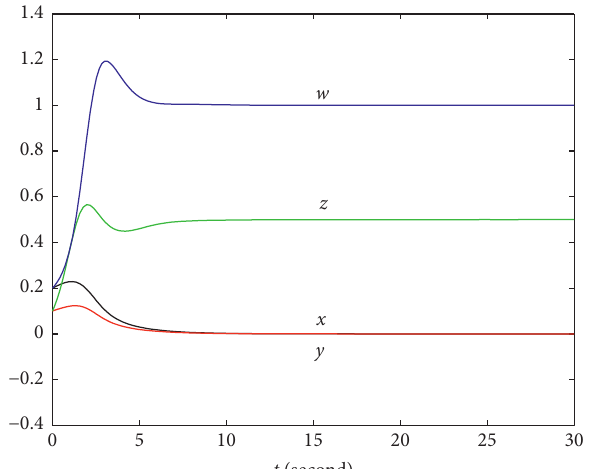
Figure 1: The values a � 0.5, b � 0.5, c � 2, d � 1, e � 1, f � 2, and g � 2 are used. So, we get the stable solution ( x � 0, y � 0, z � 0.5, and w � 1).